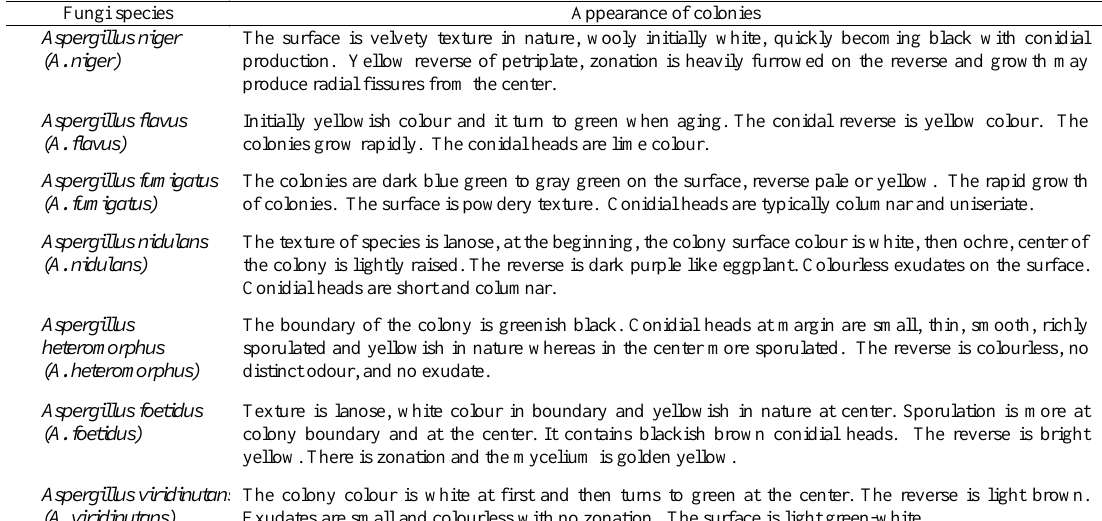
Table 2: Morphological characteristics of isolated fungi species from tannery industry wastewater contaminated soil Fungi